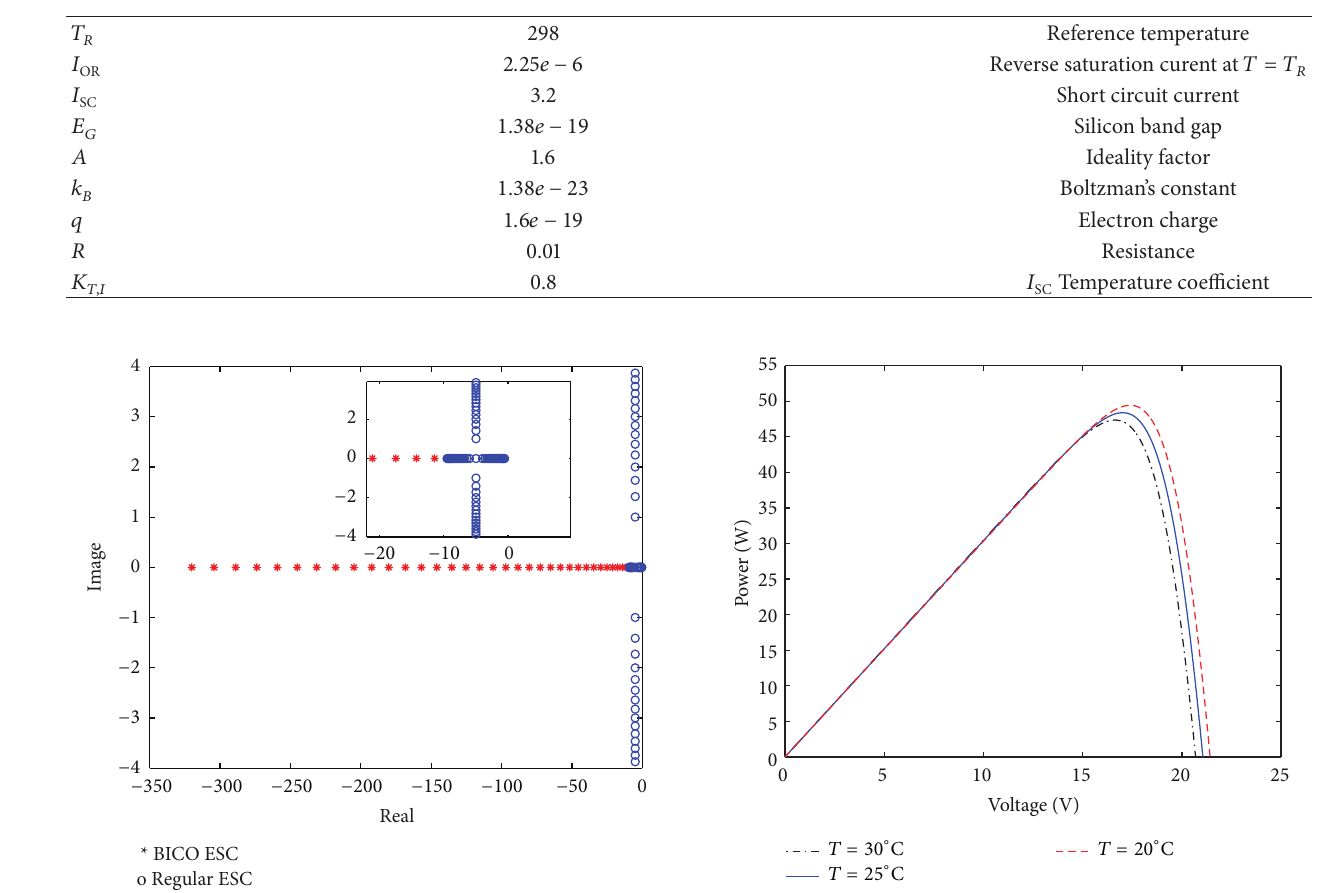
Table 2: Values of the considered PV model [3].